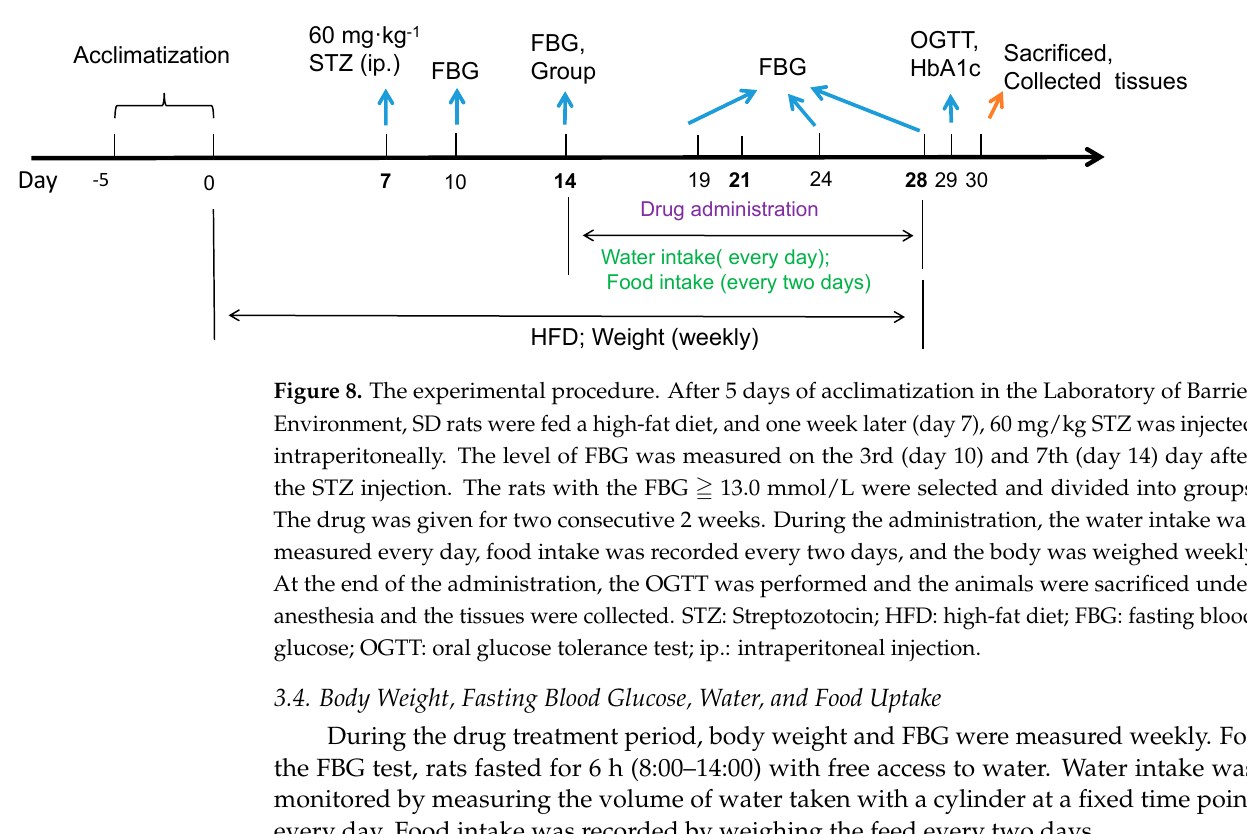
Molecules 2023 , 28 , x FOR PEER REVIEW 10 of 17 3.3. Animal Model and Treatment Hyperglycemic rats received a high-fat diet containing (wt/wt) 60% fat, 20% protein, and 20% carbohydrate for 4 weeks. After one week on a high-fat diet, a single intraperito- neal injection of 60 mg/kg b.w. STZ (dissolved in 0.05 M citrate buffer before use, the in- jection was completed within 20 min of preparation) was conducted in hyperglycemic rats. Normal rats ( n = 6) were fed with a normal diet and injected with equal volumes of citrate buffer vehicle (5 mL/kg). On days 3 and 7 after injection, the FBG level of all animals was assessed in blood collected from the tail tip using a blood glucose meter (Accu-check, Roche), and the rats fasted for 6 h before the blood glucose test. According to the last blood glucose levels, STZ-injected rats whose FBG levels were higher than 13 mmol/L were re- garded as successful hyperglycemic model rats and they were randomly divided into three groups: model group ( n = 9), model+ B4 (2.5 mg/kg, n = 8) group, and model+DAPA (0.1 mg/kg, n = 8) group. B4 was injected intraperitoneally with a volume of 5 mL/kg , Dapagliflozin was administrated intragastrically in a volume of 20 mL/kg, and rats in the